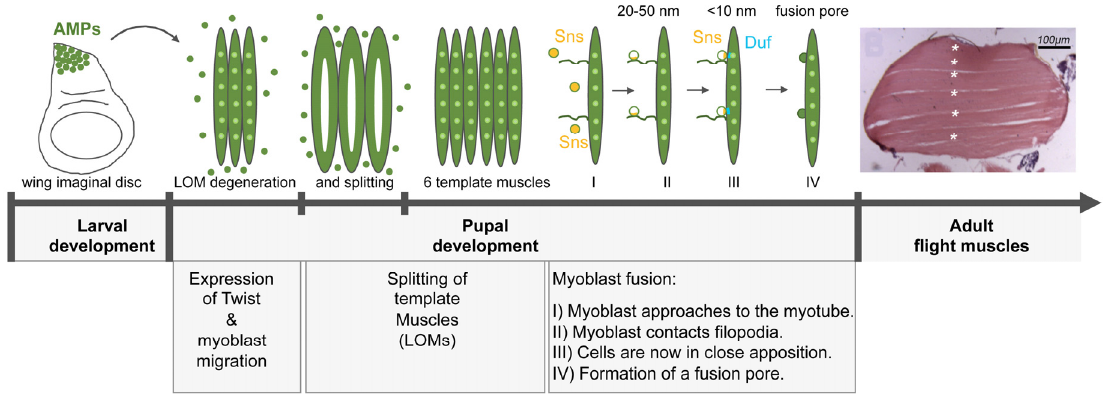
Figure 7. Model for IFM myoblast fusion. The larval oblique muscles (LOMs) that give rise to the DLM flight muscles partially degenerate 0–8 h after pupal formation (APF). The AMPs begin to migrate towards the LOMs and fuse to them. This induces the splitting of the LOMs at 12 h APF leading to the formation of six DLM fibers. (I) During IFM myoblast fusion, the myoblasts approach to the myotube and fusion-relevant genes like sns are switches on (yellow cells). (II) Next, the myoblasts make contact to the filopodia and Sns (yellow) is restricted to the contact site. The distance between the membranes is 20–50 nm. (III) The myoblast comes in close proximity to the myotube/template muscle and the cell adhesion molecule Duf (blue) is recruited to the site of cell–cell contact. The cells are now in close apposition (<10 nm). (IV) Finally, multiple fusion pores form, enlarge and the myoblast is incorporated into the myotube by the expansion of the fusion pore. Fusion is completed by 36 h APF. Table 1. List of proteins that are important for somatic myoblast fusion and play a role in longitudinal and/or DLM flight muscle